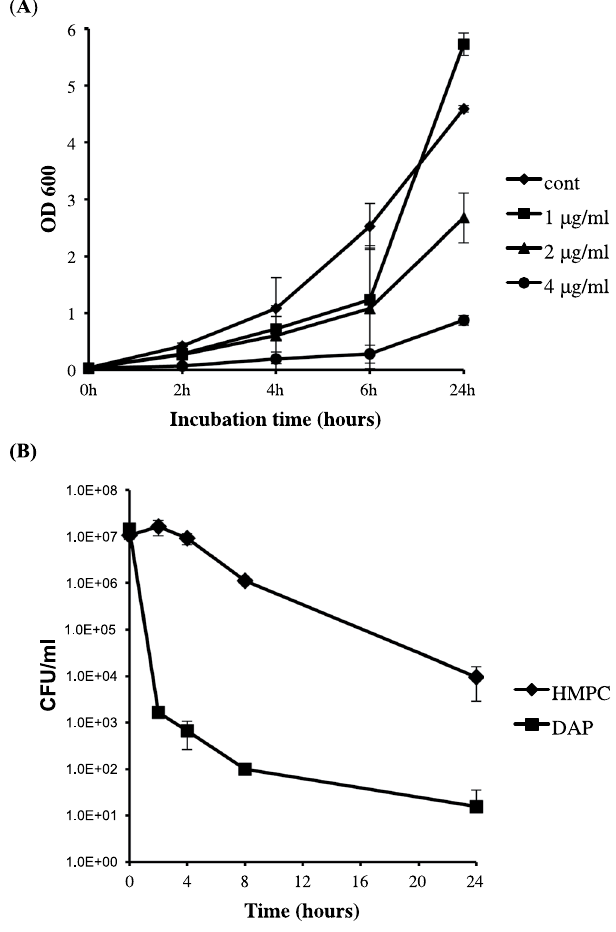
Figure 2. ( A ) S. aureus MW2 growth inhibition in the presence of 1–4 μ g/ml HMPC. Bacterial culture aliquots were periodically taken during log-phase growth to measure the optical density at 600 nm (OD 600 ). Data show the mean + / − standard deviation of triplicate values, and significant differences from the control were observed for all concentrations tested (p < 0.05 by two-tailed t-test). ( B ) Killing assay with HMPC or daptomycin (DAP). Log-phase cultures were treated with 16 μ g/ml of HMPC (4xMIC) or 10 μ g/ml DAP and were incubated at 37 °C with shaking at 220 rpm. Bacterial survival was monitored after 2, 4, 8, and 24 hours by dilutional plating and enumeration of CFU/ml at each time point. The differences between HMPC and DAP are significant at all time points except T0 (p < 0.05 by two-tailed